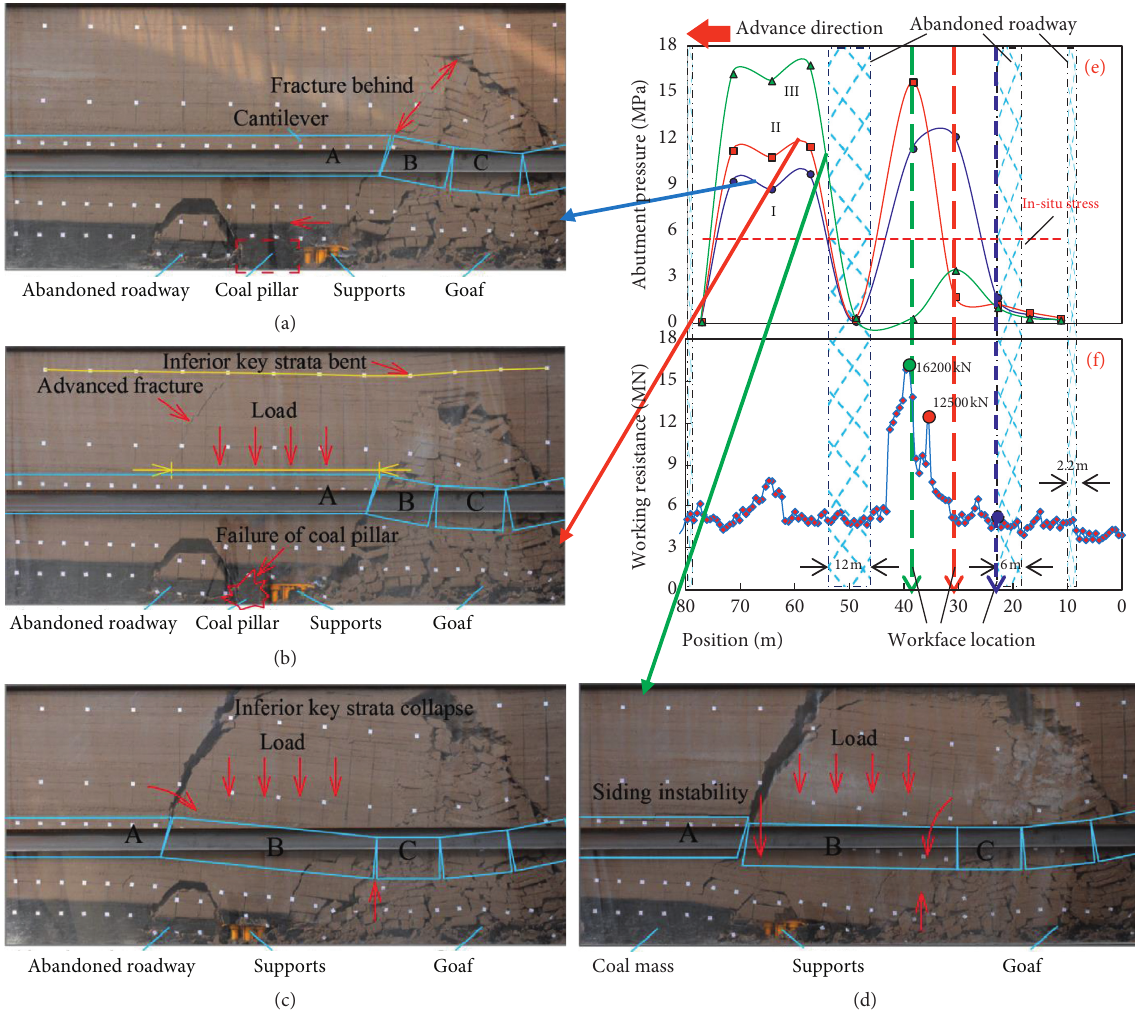
Figure 5: The advancing processes of long-wall face across to abandoned roadway (ii). (a) At the position of 23m, (b) at the position of 31m, (c) at the position of 35m, (d) at the position of 39 m, (e) abutment pressure curves, and (f) working resistance